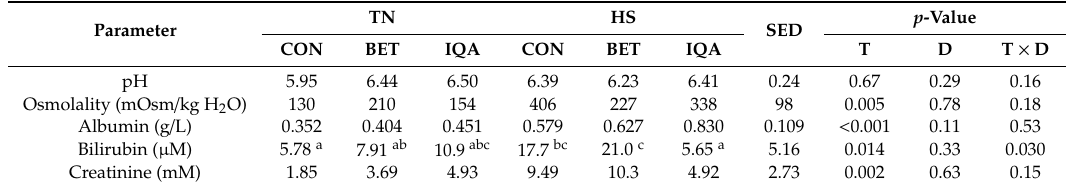
Table 4. E ff ect of thermoneutral (TN) and heat stress (HS) conditions and control (CON), betaine (BET) or isoquinoline alkaloids (IQA) diets on urine biochemistry and metabolites 1